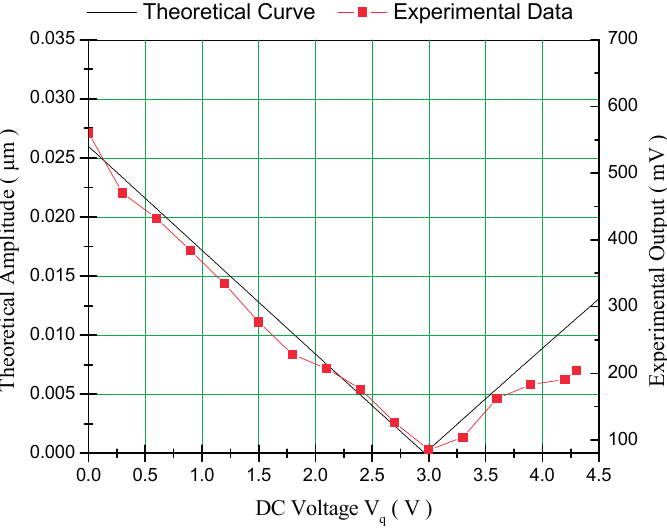
Figure 9. Relationships between the quadrature signal and the compensation voltage when the method of double group loading was